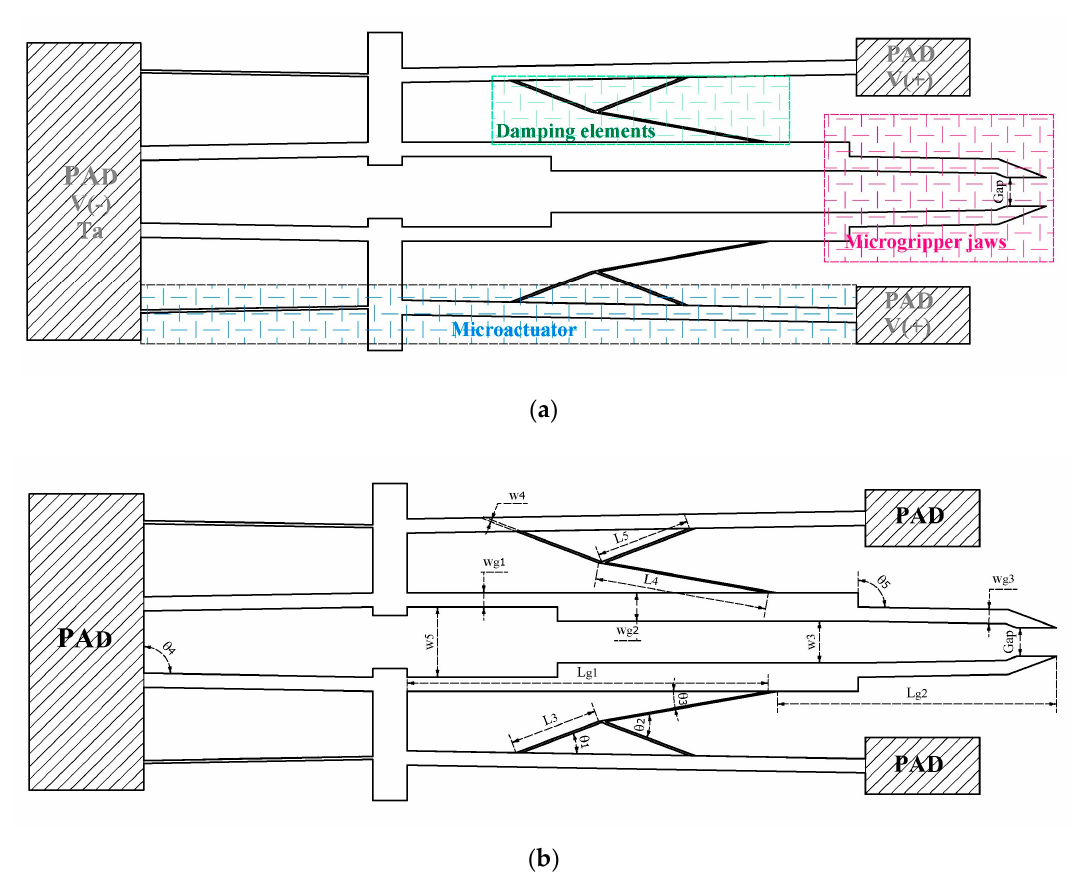
Figure 2. ( a ) Elements and ( b ) geometric sizes of the novel electrothermal microgripper. Table 3. Mechanical and electrical parameters of Si [9,24,33,41].